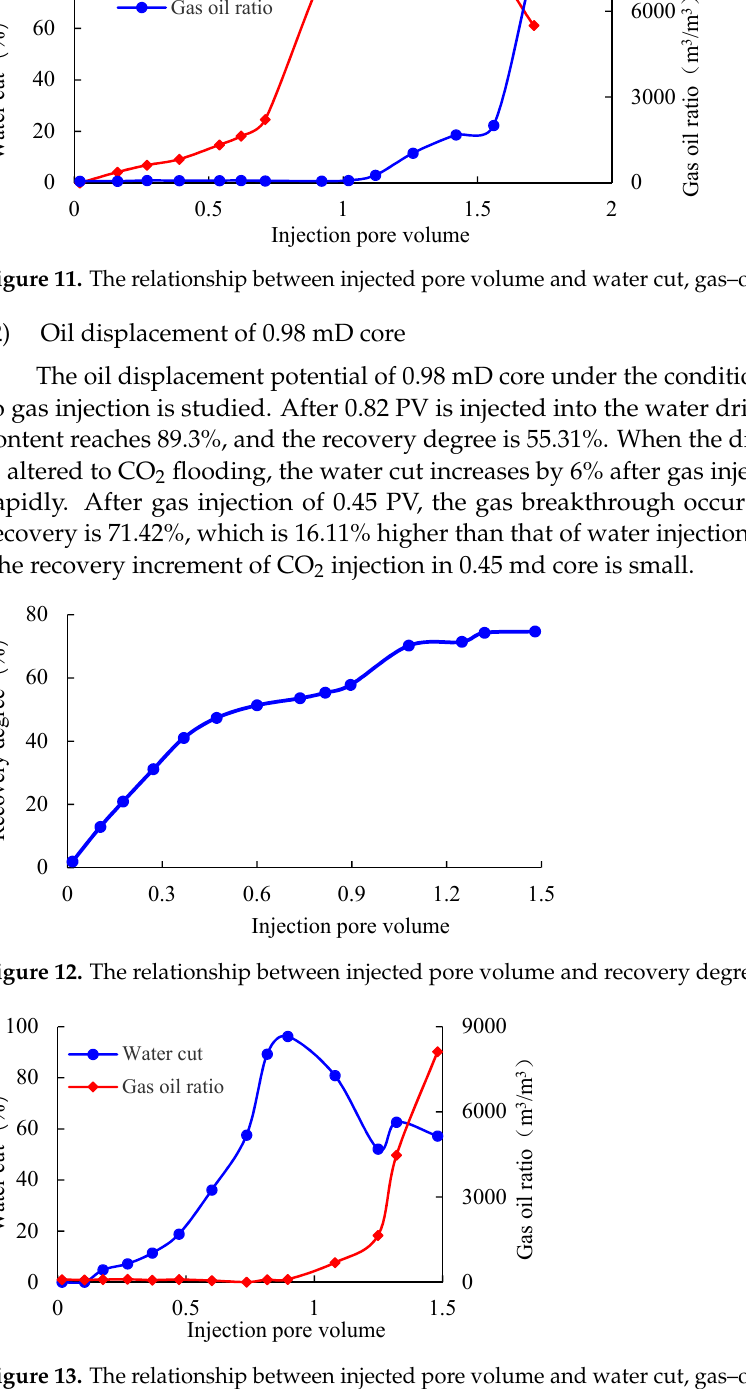
Figure 10. The relationship between injected pore volume and recovery degree of 0.45 mD core.